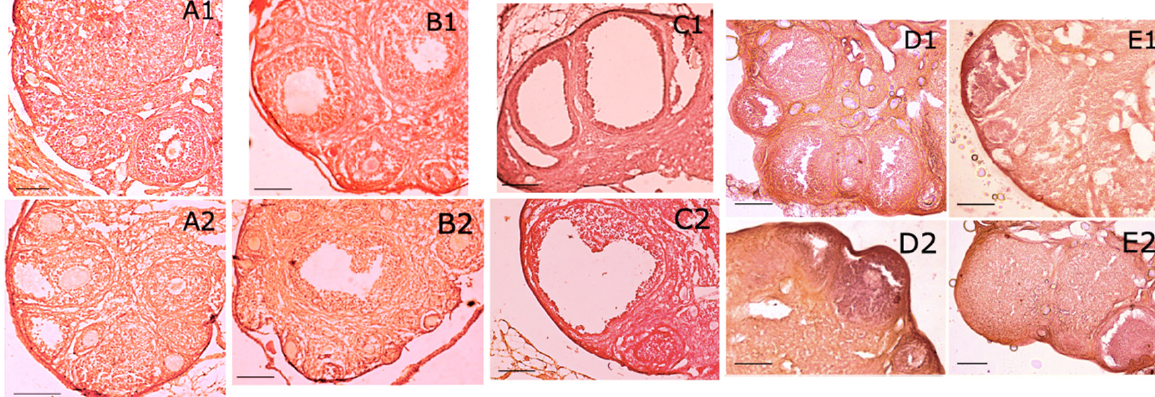
Figure 3. Ovarian histology of mice at the end of the 21 day-treatment. ( A1 , A2 ) Ovarian sections from mice that received plain water (negative control), showing primary, secondary, and tertiary follicles as well as a corpus luteum ( A1 ). These features are typical of normally cycling mice. ( B1 , B2 ) Sections from mice subjected to 21-day treatment with DCIns 250, showing primary, secondary, tertiary and cystic follicles devoid of oocytes. These features resemble typical signs of PCOS. ( C1 , C2 ) Sections from mice subjected to 21-day treatment with letrozole (positive controls), showing paucity of follicles and a large cyst, typically modeling human PCOS. ( D1 , D2 ) Sections from mice subjected to 21-day treatment with DCIns 500, showing secondary and tertiary follicles as well as follicles with signs of hyperproliferation and extension of the stromal compartment. ( E1 , E2 ) Sections from mice subjected to 21-day treatment with DCIns 1000, showing paucity of secondary and tertiary follicles as well as large follicles with signs of hyperproliferation and extension of the stromal compartment. Hematoxylin-eosin. Scale bars, 100 μ m.